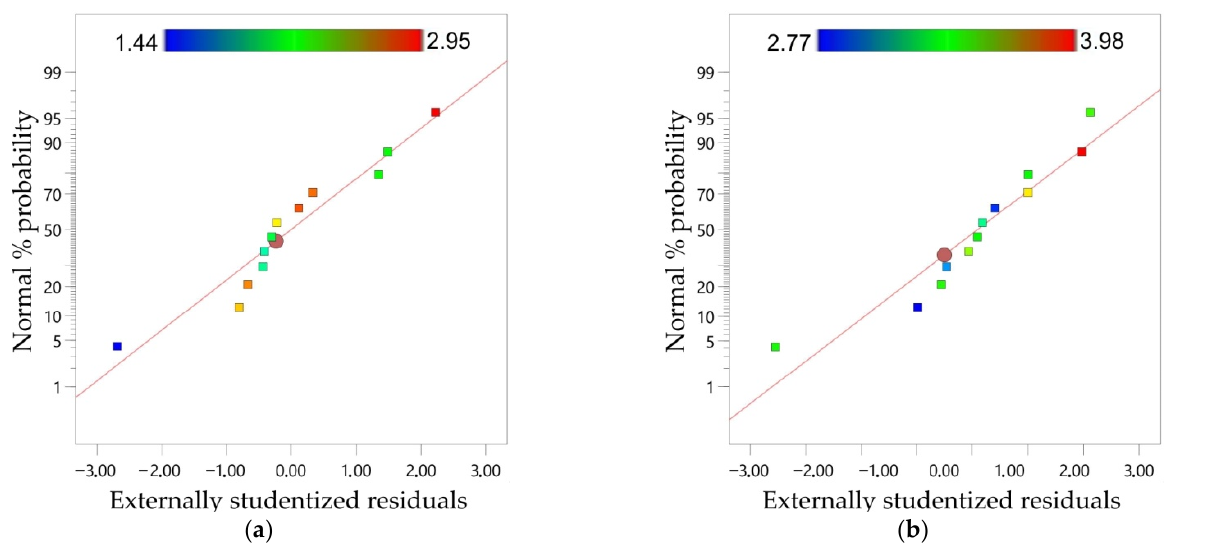
Figure 13. Normal probability plot of residuals for the Sa parameter measured on the ( a ) inner and ( b ) outer side of the drawpiece.